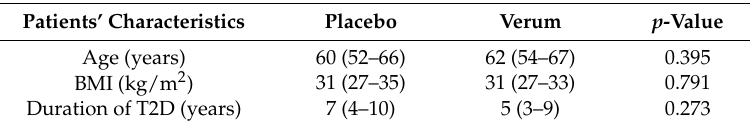
Table 1. Patients’ characteristics at baseline.